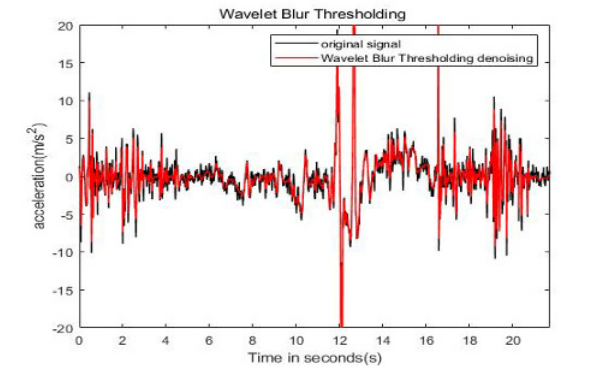
Fig. 4. Figure with Signal data processed by wavelet fuzzy threshold